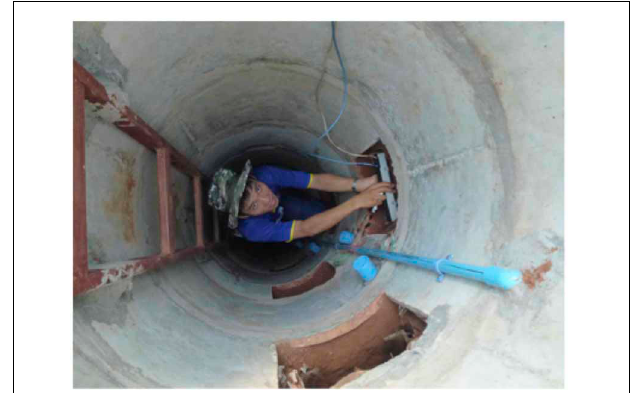
FIGURE 5 | Root scanning in access shaft (5m deep) in Lao PDR